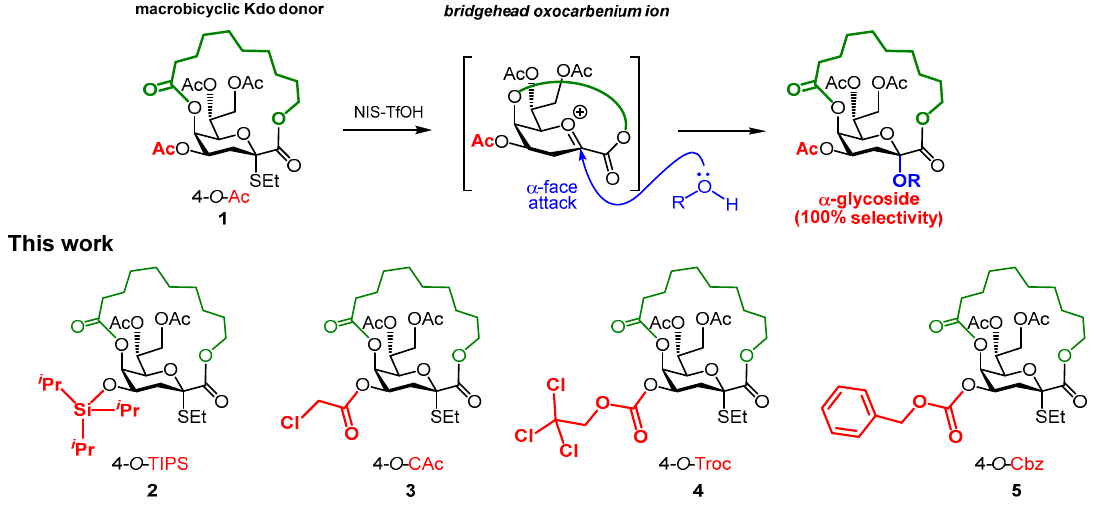
Figure 1. Macrobicyclic Kdo donors developed in previous and present